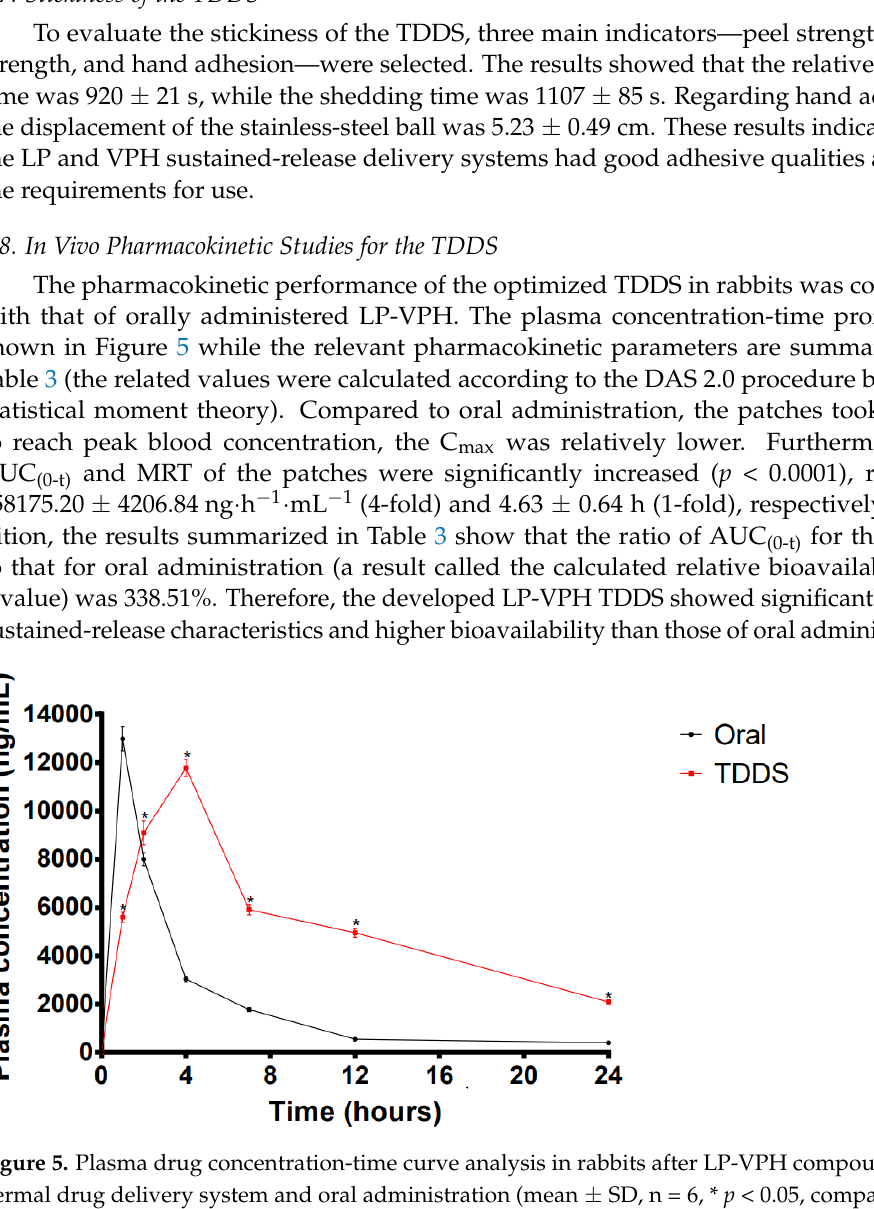
Table 4. Results of skin irritation (n = 6).